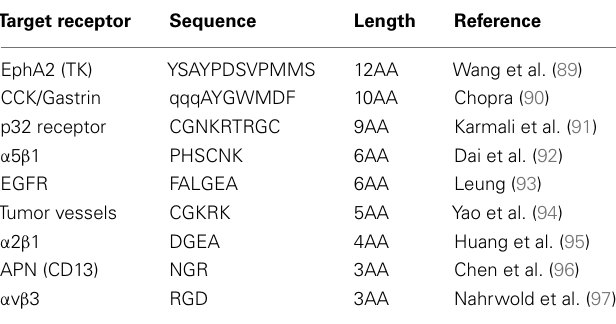
Table 2 | Peptides identified as potential tools to target tumor